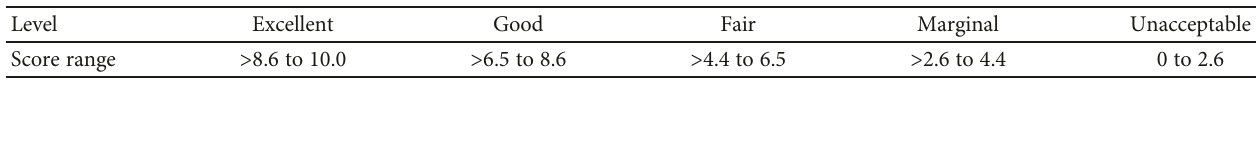
Table 5: Side impact dummy bio fi delity